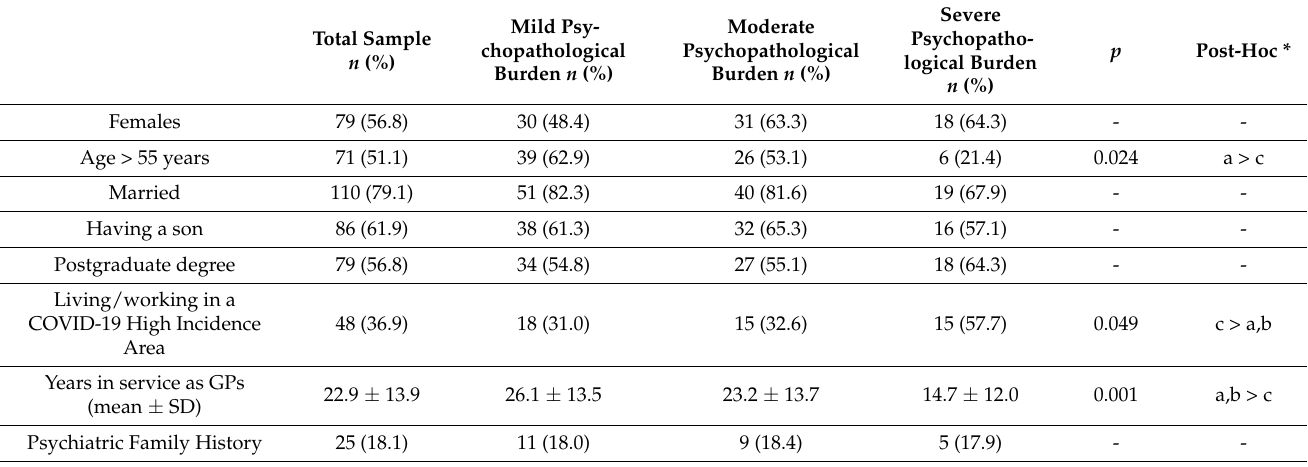
Table 4. Sociodemographic and COVID-19 characteristics in the total sample ( n = 139) and in the Mild psychopathological burden ( n = 62), Moderate psychopathological burden ( n = 49) and Severe psychopathological burden ( n = 28)